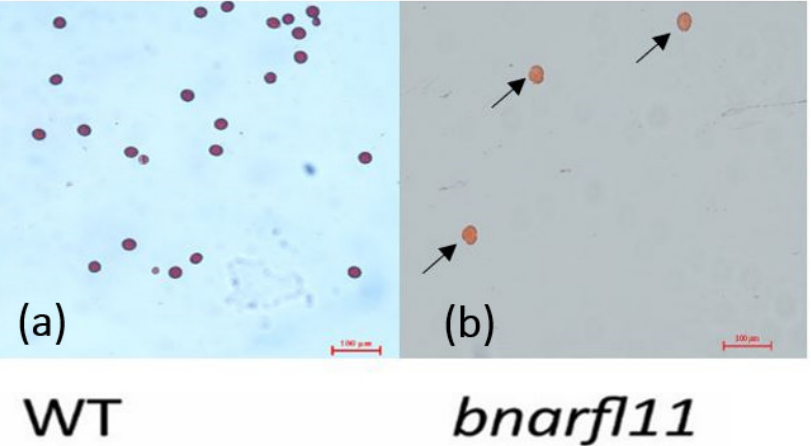
Figure 6. Pollen viability test staining with 1% ( w / v ) acetocarmine solution. ( a ) Shows WT pollens. ( b ) Arrows indicating bnarfl11 degenerated pollens.